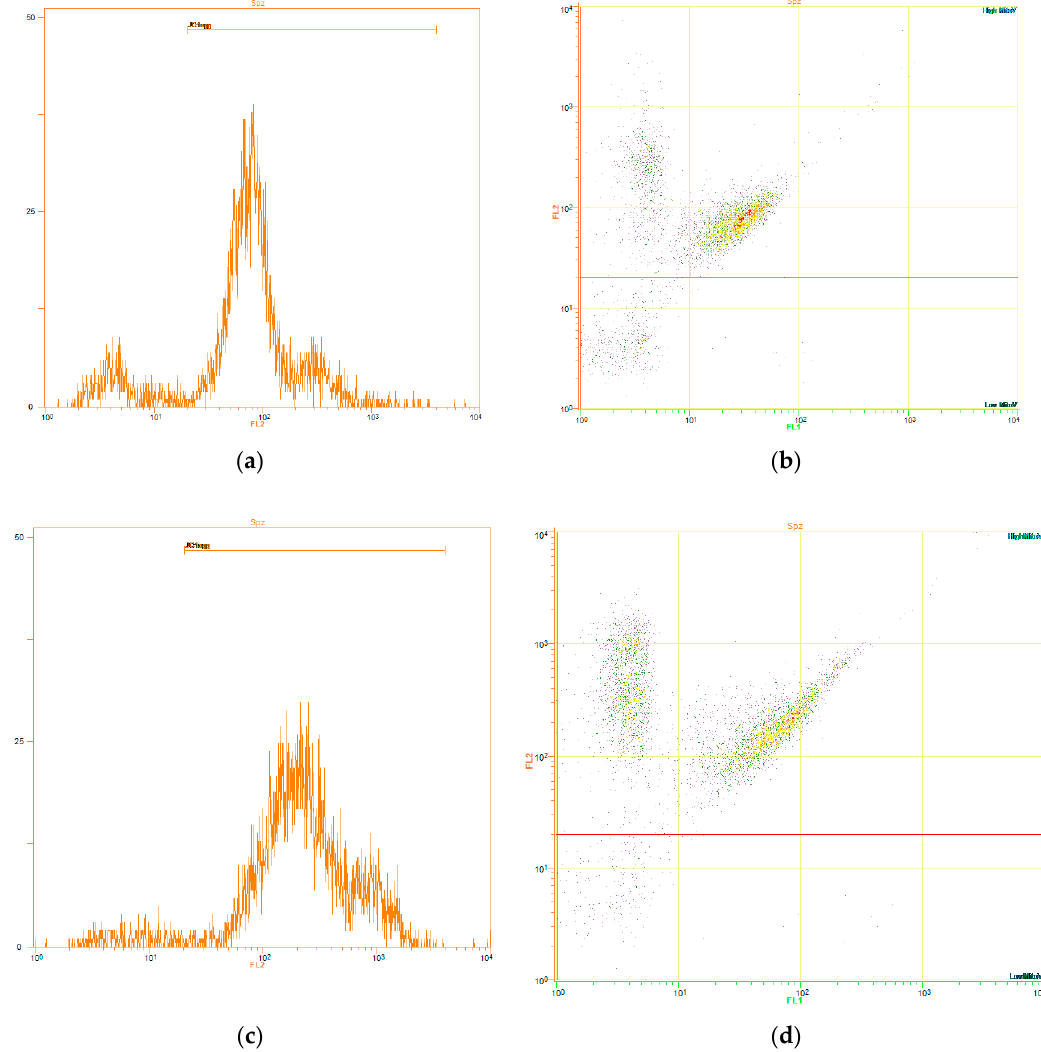
Figure 3. Mitochondrial membrane potential ( ∆Ψ m, JC1). Representative JC1 agg (FL2 channel) histograms for the control ( a ) and 15-15-15 light-stimulation pattern ( c ). Representative FL1/FL2 dot-plots for the control ( b ) and 15-15-15 light-stimulation pattern ( d ). Spermatozoa with high mitochondrial membrane potential (JC1 agg ) appear in the upper half of the Figure. Percentages of spermatozoa with high mitochondrial membrane potential (JC1 agg ) were significantly ( p < 0.05) higher in the 15-15-15 light-stimulation pattern than in the